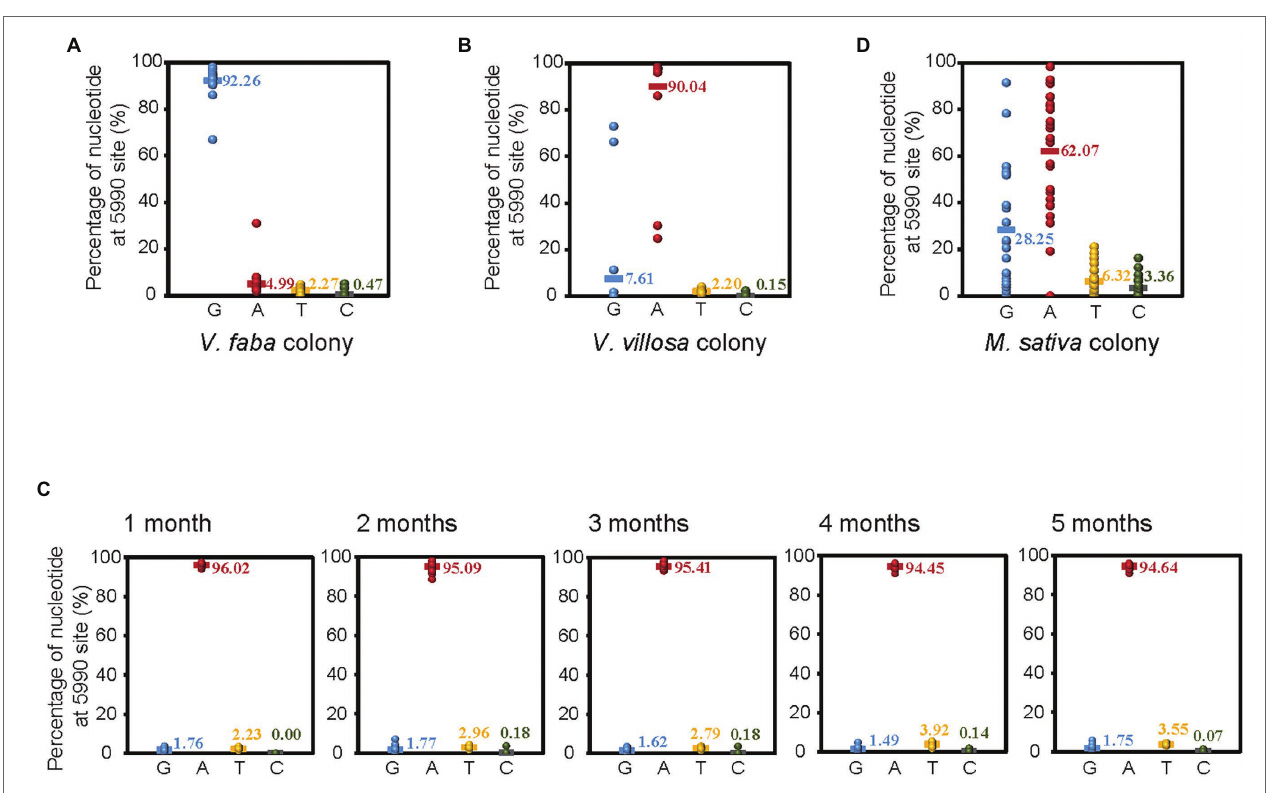
FIGURE 2 | Divergence of SNP at site 5,990 of APV in different colonies of pea aphids. (A) Vicia faba colony. (B) Vicia villosa colony. (C) V. villosa colony that was raised on V. faba for 1–5 months. (D) Medicago sativa colony. Twenty individual pea aphids were sequenced in (A–C) , and 27 individuals were sequenced in (D)